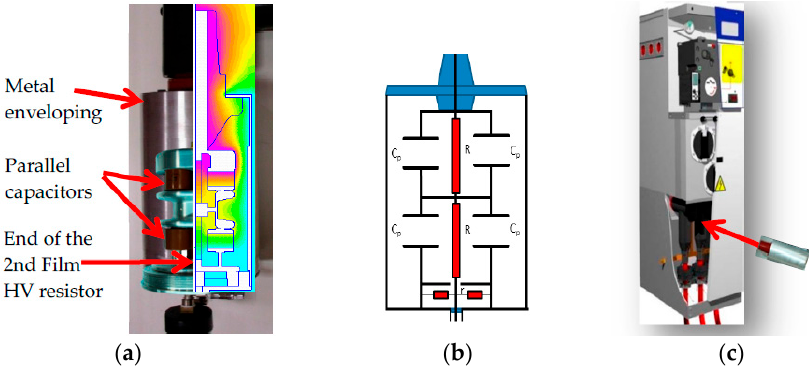
Figure 1. Voltage divider for MV switchgear under metal enclosure: ( a ) The cut-away view of the voltage divider enclosed in a metallic enveloping; ( b ) schematic electrical circuit; ( c ) general view of the HV divider sensor to be connected in a MV cabin.